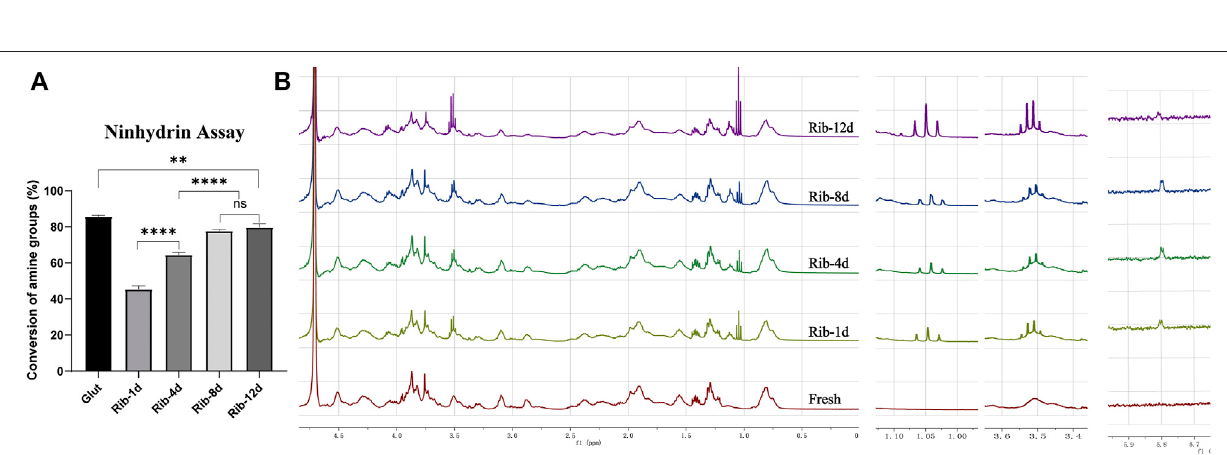
FIGURE3| ChangesinthereactivegroupsoftheBP. (A) Ninhydrinassaytoestimatetheconversionofaminegroups( n =3)intheBP. (B) Representative 1 H-NMR spectrumofthehydrolyzedproductoftheBP.FreshBP,brown;Rib-1d,yellow;Rib-4d,green;Rib-8d, blue;Rib-12d,purple(* p < 0.05,** p < 0.01,and*** p < 0.001;ns represents no signi fi cant